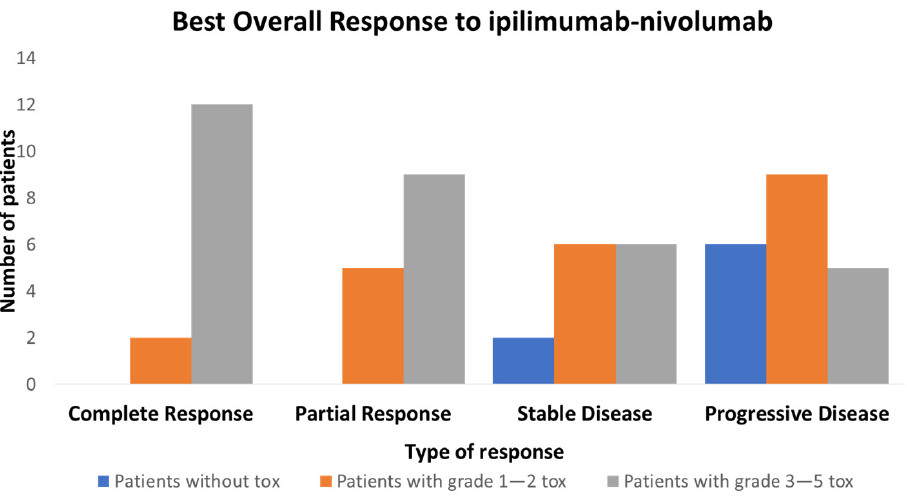
Figure 2. Relationship between best overall response (BOR) following RECIST 1.1 and maximum toxicity grade divided in 3 groups: patients without toxicity, patients with Grade 1–2 toxicity and patients with Grade 3–5 toxicity.